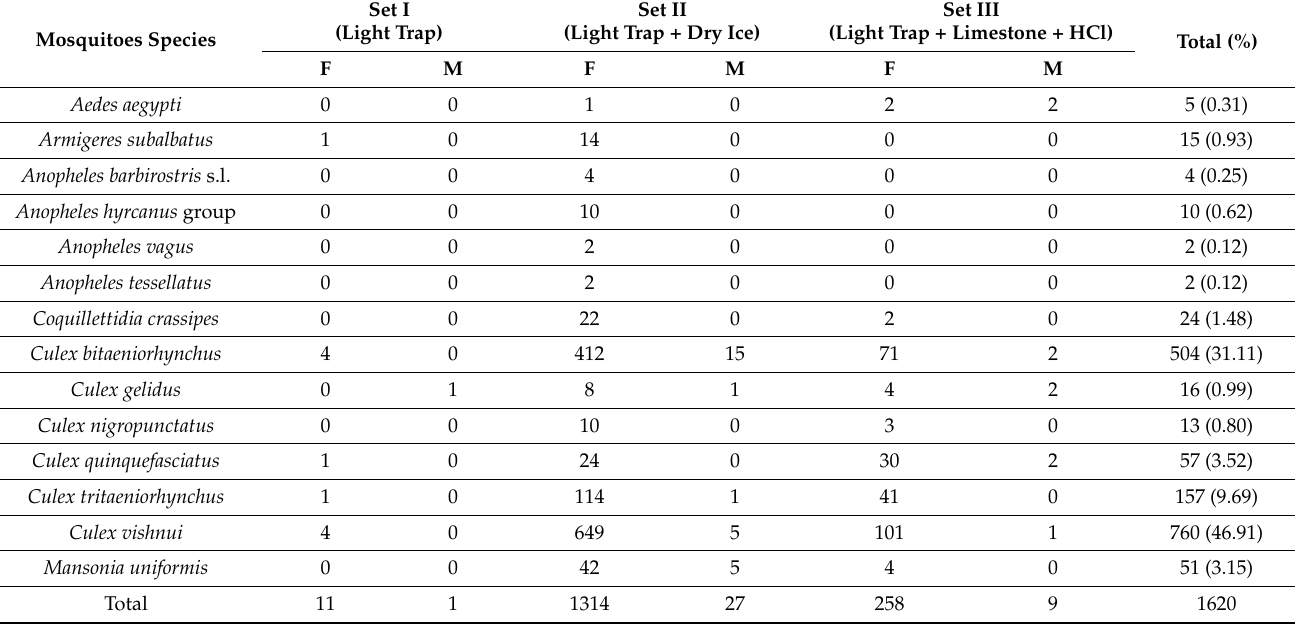
Table 2. Numbers and species of mosquitoes collected from three locations by three different trap sets in Sanpatong District, Chiang Mai Province, Thailand.